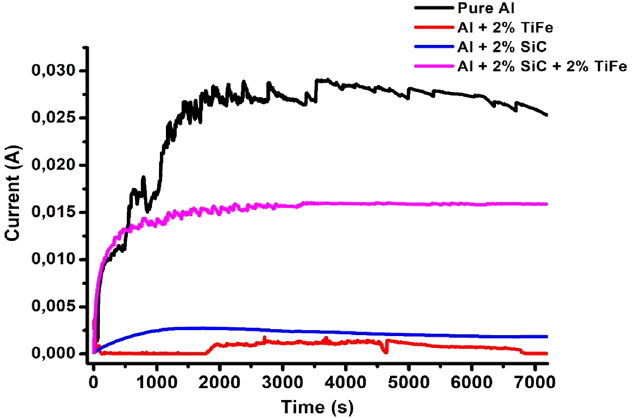
Fig. 3. Potentiostatic plot of pure aluminium and sintered